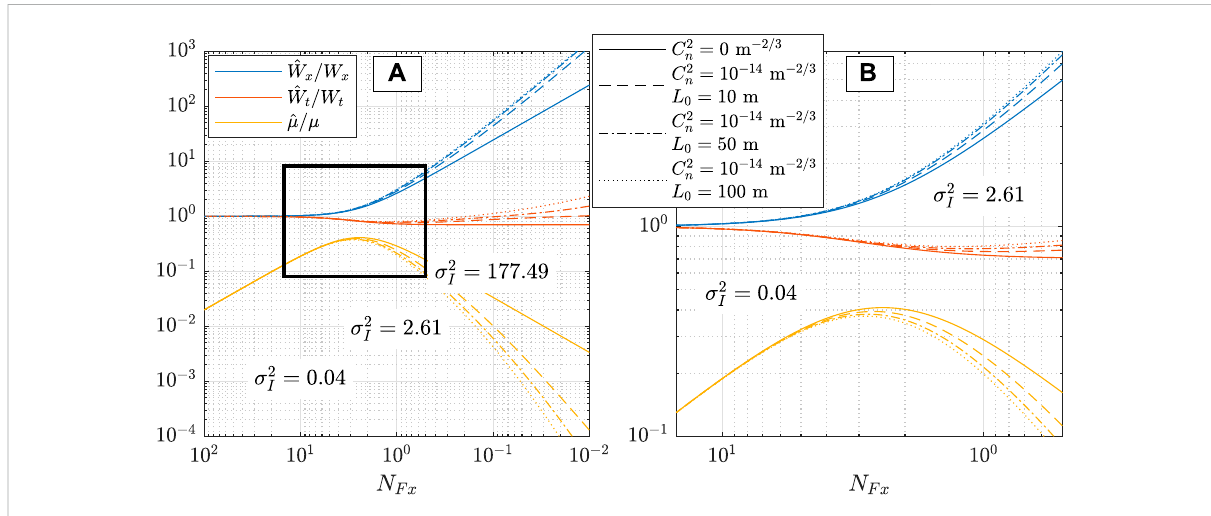
FIGURE 1 (A) ^ W x / W x , ^ W t / W t , and ^ μ / μ from Eq. 19 versus Fresnel number N Fx . (B) Zoomed-in view of ^ W x / W x , ^ W t / W t , and ^ μ / μ over the boxed region in (A) . Thesolid,dashed,dashed-dotted,anddottedtracesshowtheresultsinfreespace ( C 2 n (cid:1) 0m − 2/3 ) andatmosphericturbulence( C 2 n (cid:1) 10 − 14 m − 2/3 with L 0 =10 m, 50 m, and 100 m), respectively. The text annotations report the weak turbulence spherical wave scintillation index values corresponding N Fx . These results apply to a twisted space-time beam with parameter values equal to λ c =1 μ m, W x =2 cm, δ x =0.9 W x , W t =1